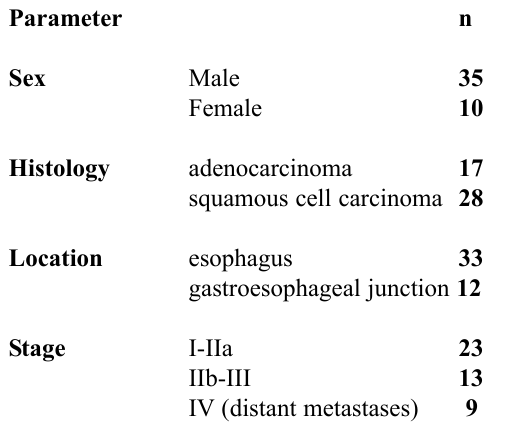
Table 1 . Patient demographics Parameter